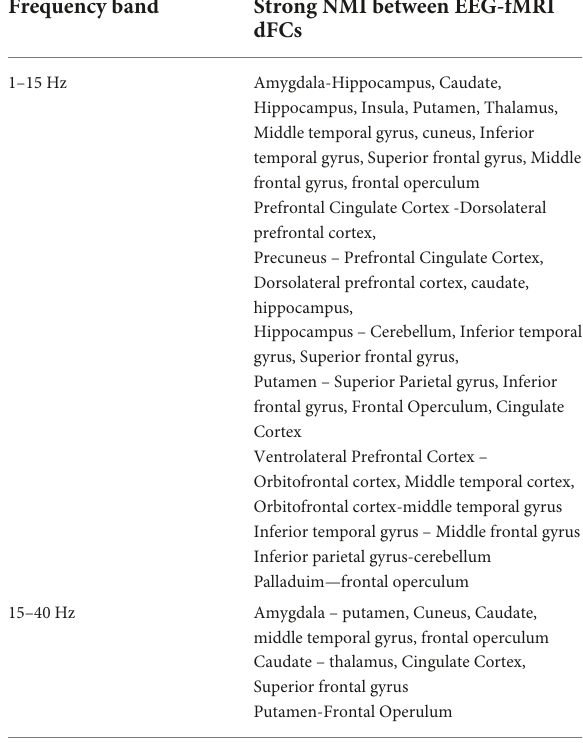
TABLE 3 The results of the NMI method for two frequency bands. Frequency band